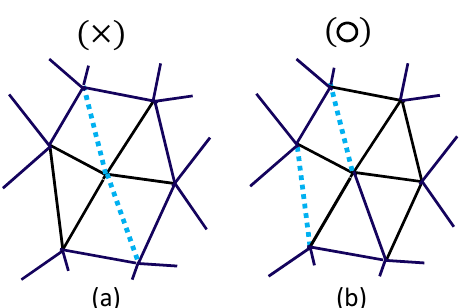
Figure 5. ( a ) A configuration that is not allowed because the two bonds of σ = 1 are connected, and ( b ) a configuration that is allowed because the two bonds of σ = 1 are separated. The maximal value χ max of the crystallization ratio of Equation (8) is not given as an input parameter in the simulations, but it is automatically determined by the constraint illustrated in the figure.